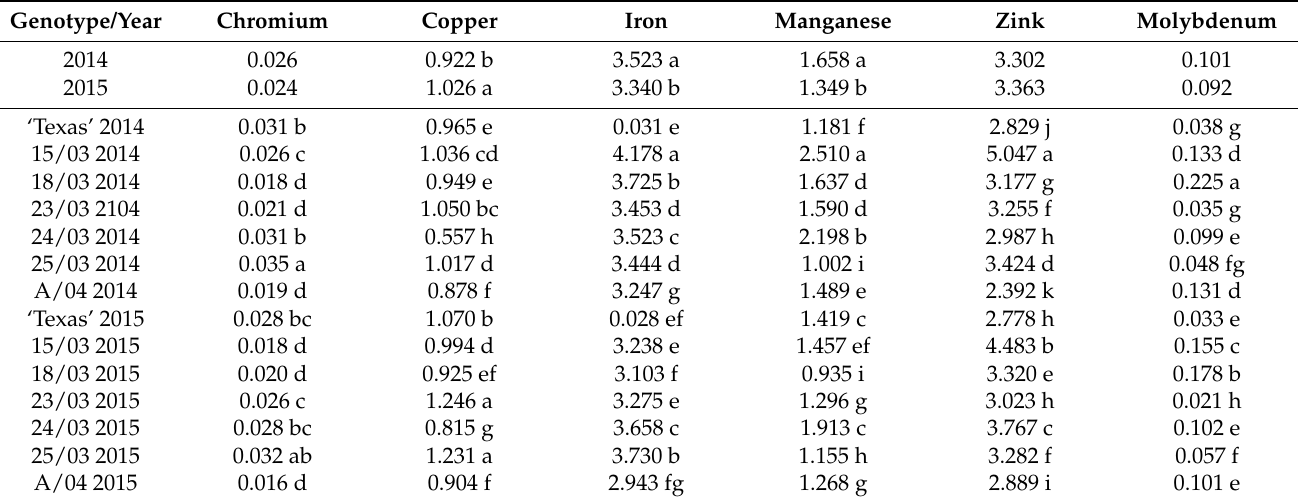
Table 6. The composition of the micro elements (mg/100 g of